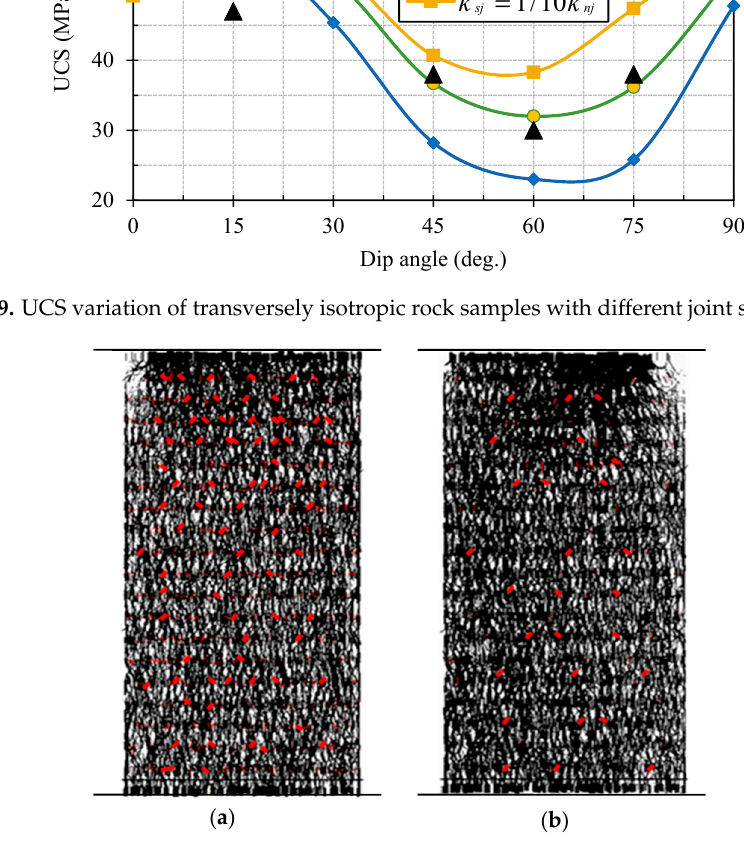
Figure 20. Force chains in the transversely isotropic rock models having horizontal interfaces with different joint normal stiffness at peak stress: ( a ) k nj = 0.15 × 10 13 N/m 3 , and ( b ) k nj = 5.0 × 10 13 N/m 3 . Note that the black chain and red chain imply compression force and tension force, respectively, and the force quantity is proportional to the chain thickness.